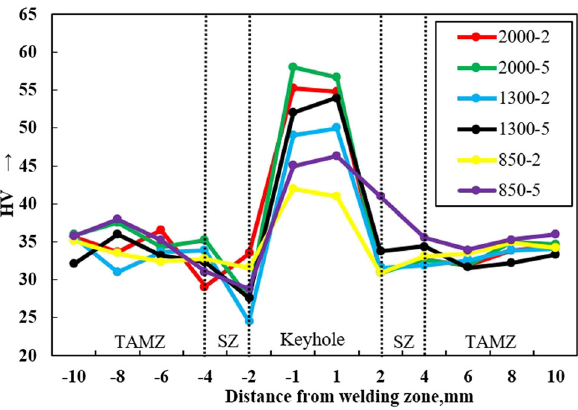
Figure 5: Microhardness distributions of welds at di ff erent rota - tional speed and dwell time.